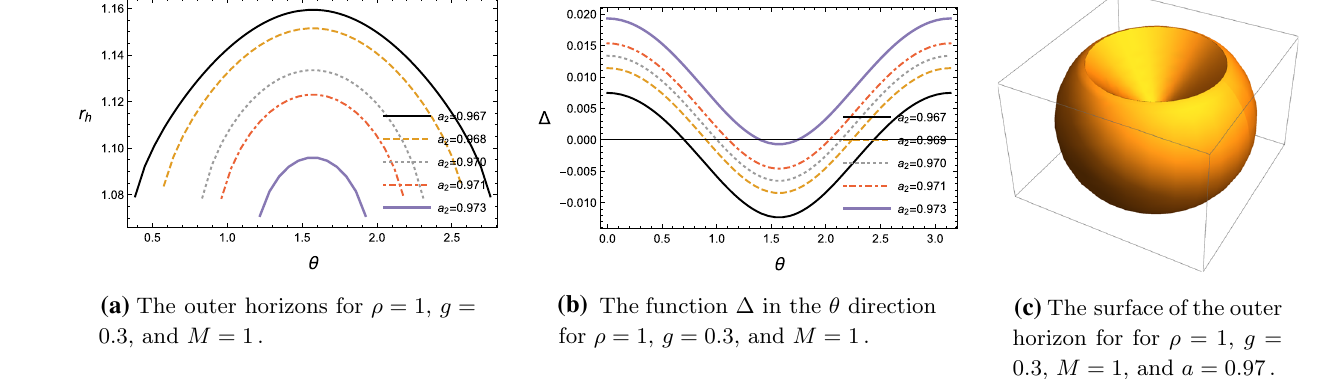
surface of the outer horizon for for ρ = 1, g = 0 . 3, M = 1, and a = 0 . 97